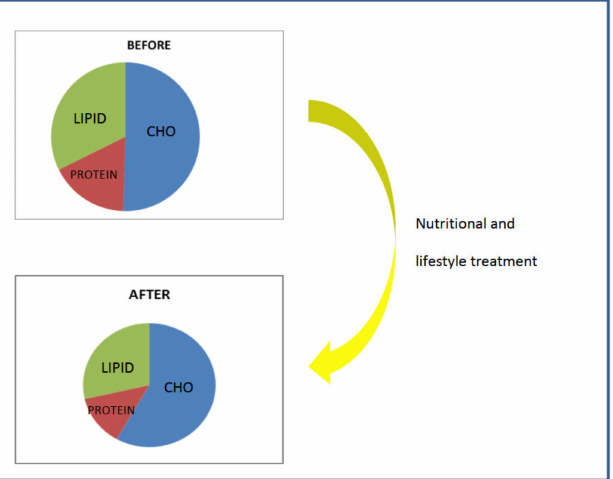
Figure 3. Macronutrients intake of the study population before and after nutritional and lifestyle intervention.